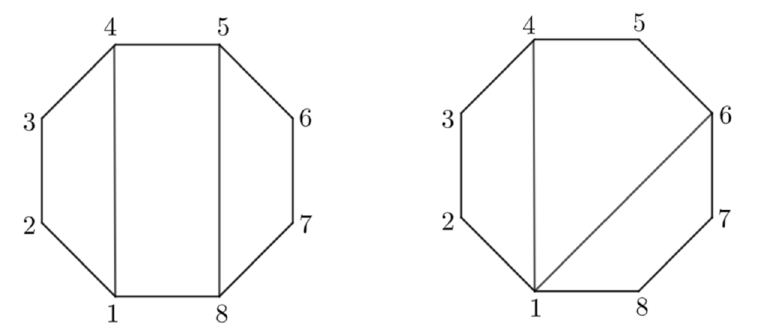
Figure 3 . The two primitives of n = 8 Stokes polytopes corresponding to quadrangulations Q = (14 , 58) and e Q = (14 , 16)